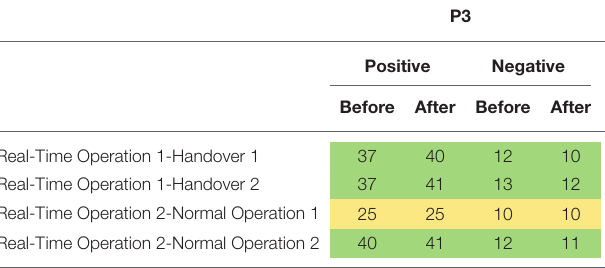
TABLE 4 | Result table of the PANAS questionnaire for P3.